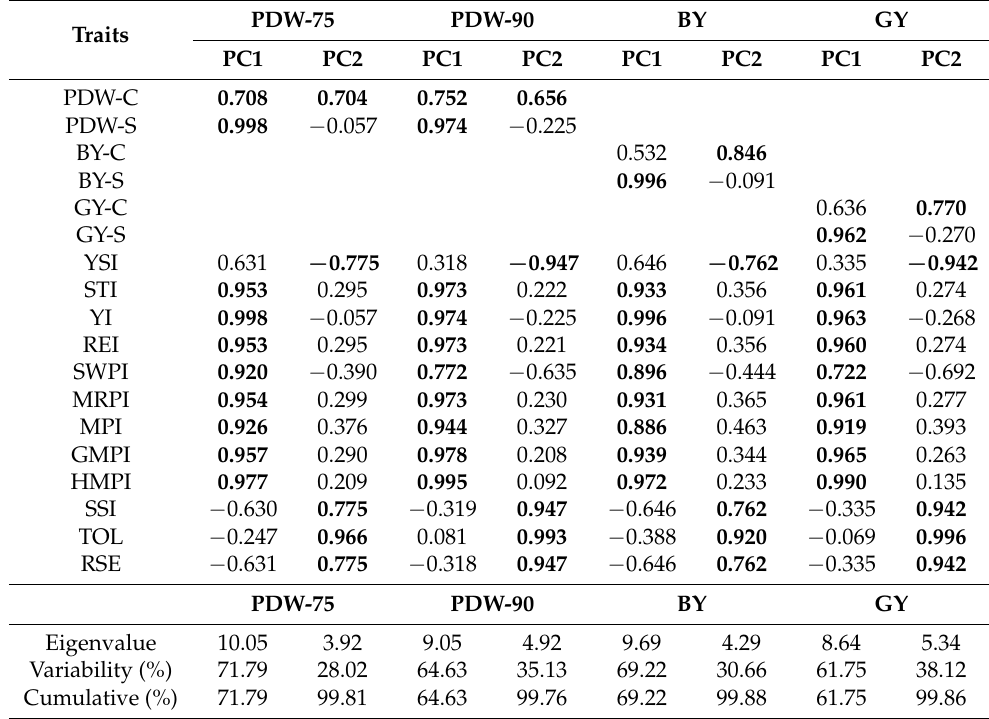
Table 5. Eigenvalue, cumulative variability, and factor loadings of the first two principal components (PCs) for plant dry weight measured at 75 days after sowing (PDW-75), plant dry weight measured at 90 days after sowing (PDW-90), biological yield (BY), and grain yield (GY) of 64 wheat genotypes grown under the control (C) and salinity stress (S)